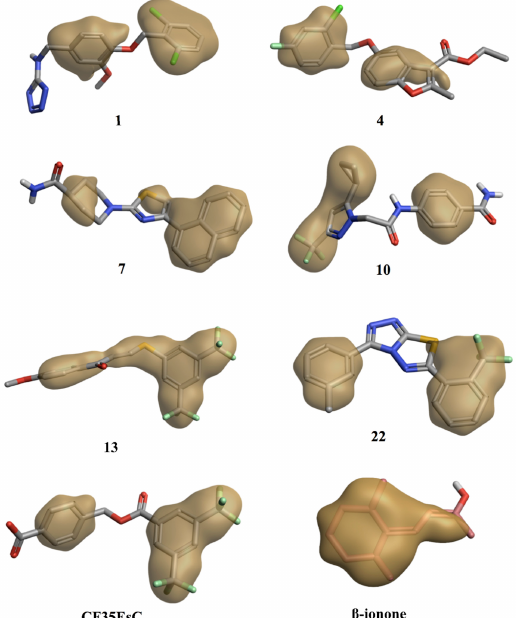
Figure 13. Hydrophobic region of the potential allosteric compounds. Compounds present either an extended planar hydrophobic region or two hydrophobic areas with a spatial orientation, which is relatively coplanar. The best scored molecular docking pose for each compound on the secondary binding pocket and the cocrystallised β -ionone were used for the hydrophobic surface calculation.